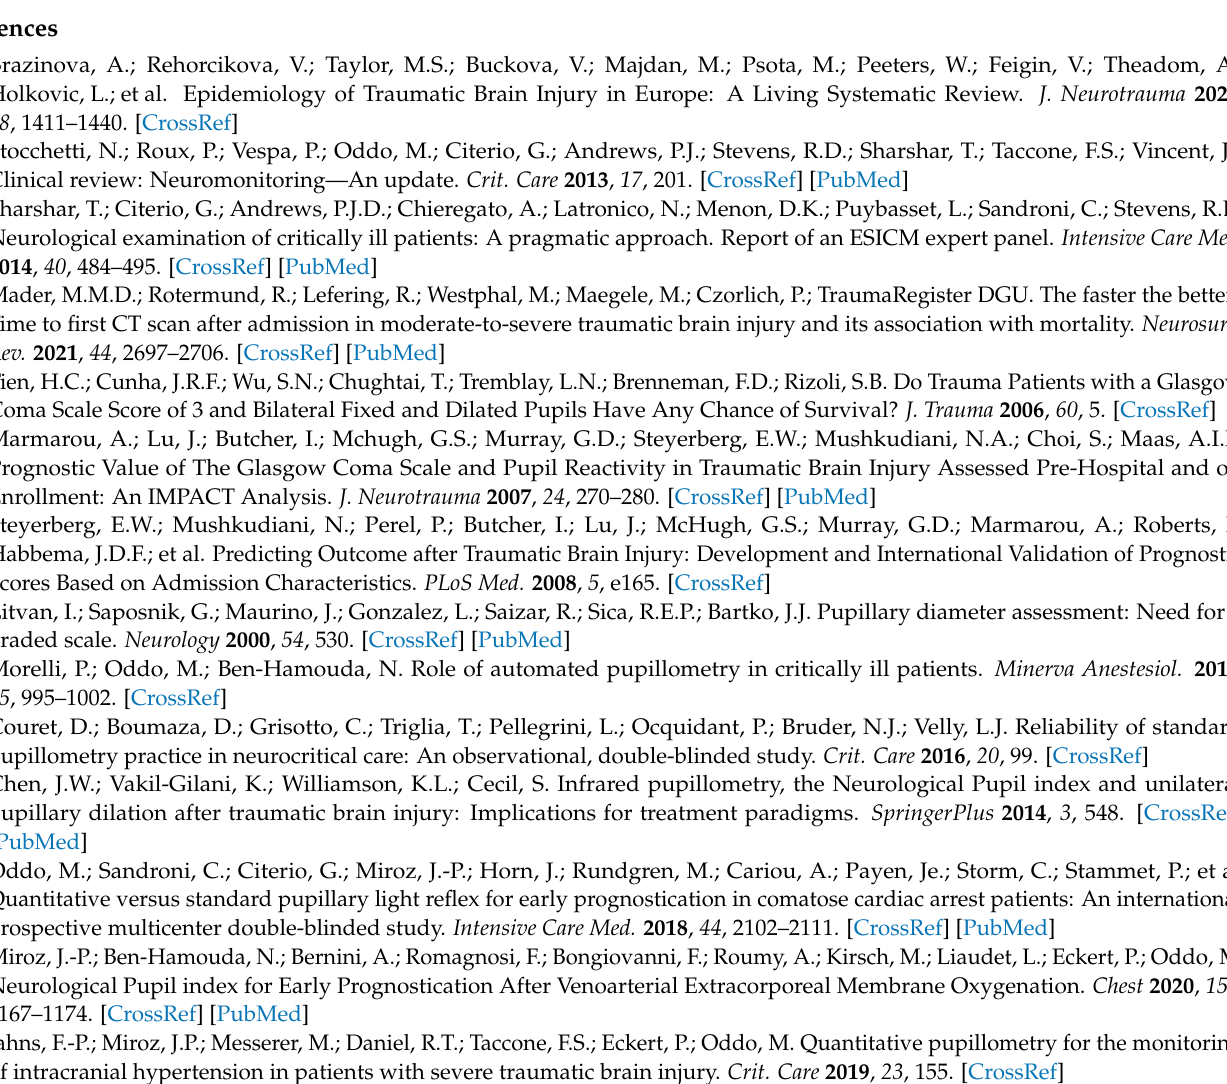
hospital mortality; Table S3: Characteristics of the study population, according to TIL-Basic, Table S4; ROC Curves according to the prediction of high TIL during ICU